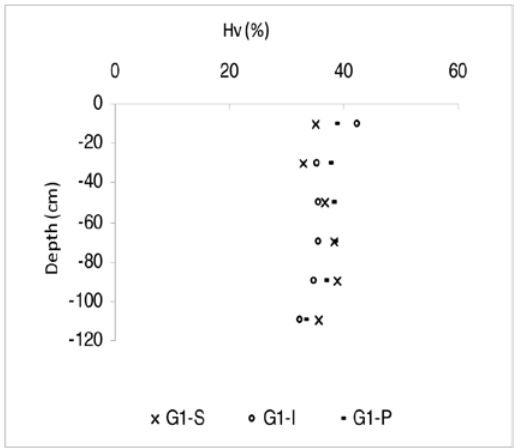
Fig. 10 - Soil water content (H , %) measured within the first reservoir v (G ). Measurements were made to 1.2 m depth at a distance of 1 1.4 m from trunks on May (29-05-2003) after a 20-day period of dryness (G -S), in July (16-07-2003) during an irrigation 1 - I) and in September (23-09-03) following the first period (G 1 heavy autumn rains (G1-P).